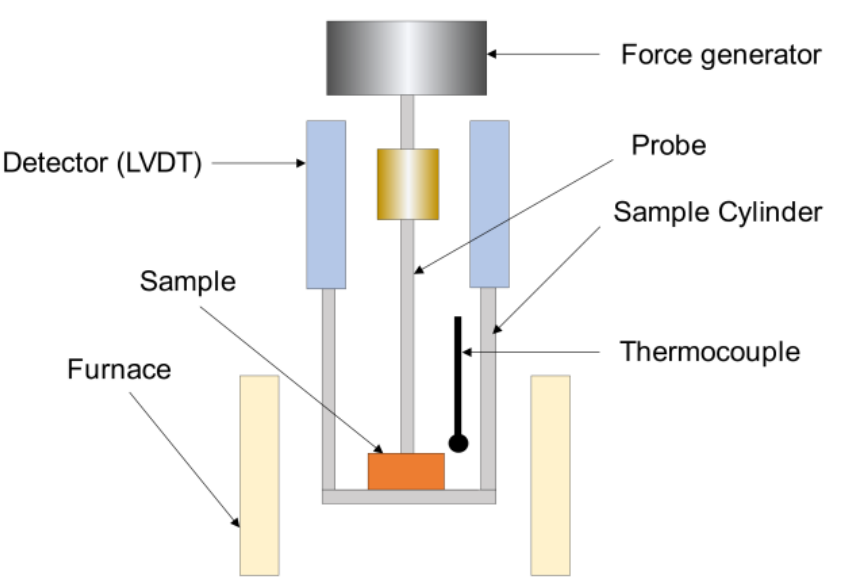
Figure 4. Schematic of the thermomechanical analyzer (TMA) [17].